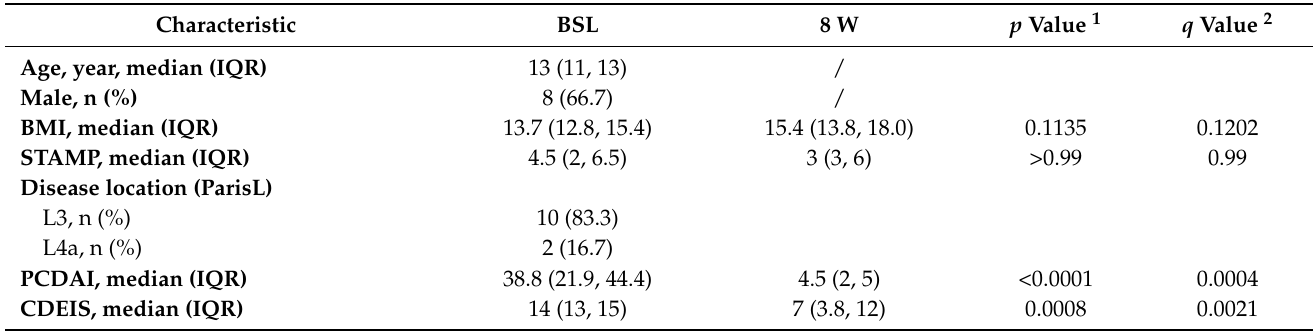
Table 1. Demographic and clinical characteristics of the pediatric CD patients before and after EEN